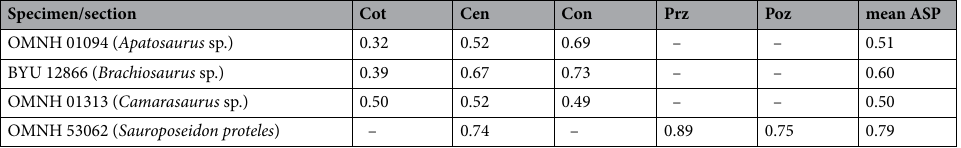
Table 4. ASP of three unidentified cervicals of the sauropod dinosaurs Apatosaurus sp., Brachiosaurus sp., and Camarasaurus sp., and of the sixth cervical vertebra of Sauroposeidon proteles (from Wedel 21 ). Cot, cotyle; Cen, mid-length of the centrum; Con, condyle; Prz, prezygapophysis; Poz,